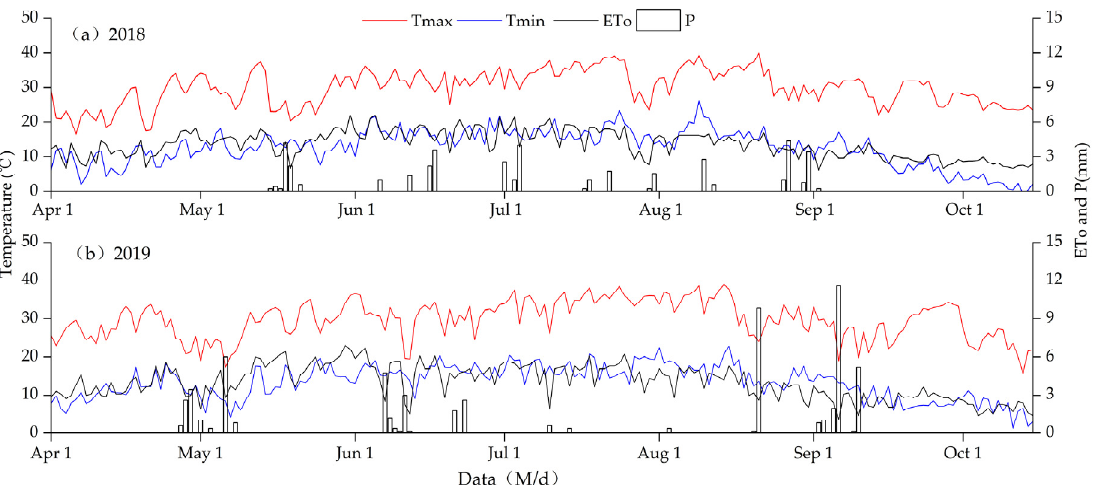
Figure 1. Maximum temperature (Tmax), minimum temperature (Tmin), reference crop evapotranspiration (ET 0 ), and precipitation (P) in ( a ) 2018 and ( b ) 2019. Table 1. Basic physical and chemical properties of soil in the test field.